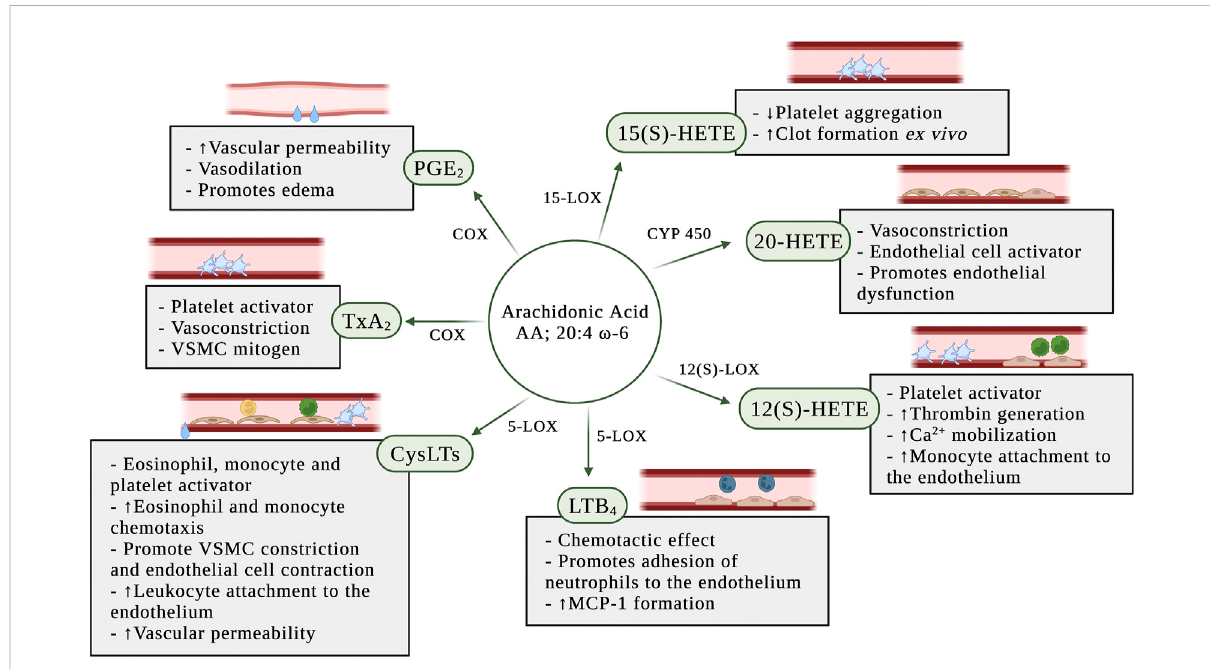
FIGURE 3 Pro-in fl ammatory effects of eicosanoids in the blood and the vascular wall. AA: arachidonic acid; COX: cyclooxygenase; CYP450: P450 cytochrome epoxygenase; CysLTs: cysteinyl leukotrienes; LTB 4 : leukotriene B 4 ; MCP-1: monocyte chemoattractant protein-1; PGE 2 : prostaglandin E 2 ; TxA 2 : thromboxane A 2 ; VSMC: vascular smooth muscle cell; 5-LOX: 5-lipoxygenase; 12(S)-LOX: 12(S)-lipoxygenase; 12(S)-HETE: 12(S)-hydroxyeicosatetraenoic acid; 15-LOX: 15-lipoxygenase; 1 5(S)-HETE: 15(S)-hydroxyeicosatetraenoic acid; 20-HETE : 20- hydroxyeicosatetraenoic